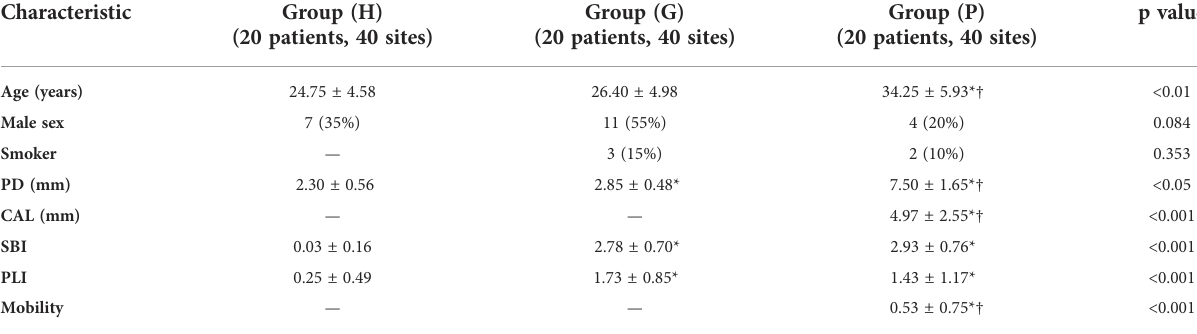
TABLE 1 Patient characteristics and periodontal parameters of sampling